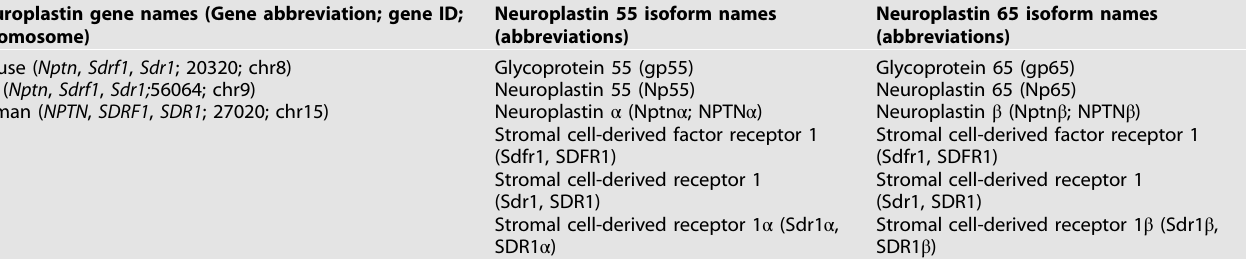
Table 1. List of abbreviations, terms, and information related to mouse, rat, and human neuroplastin gene and protein isoforms, available in literature. Neuroplastin gene names (Gene abbreviation; gene ID; chromosome)